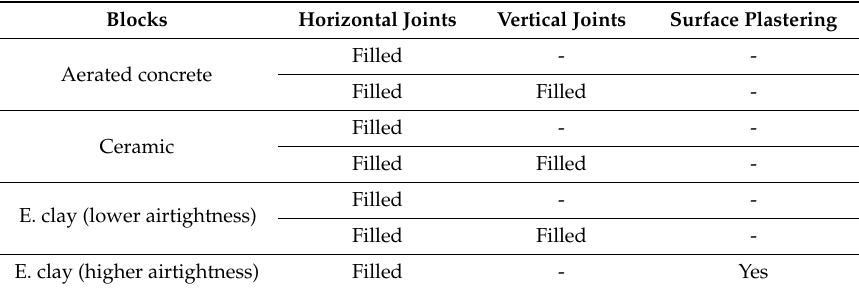
Table 1. Types of blocks and their joint filling